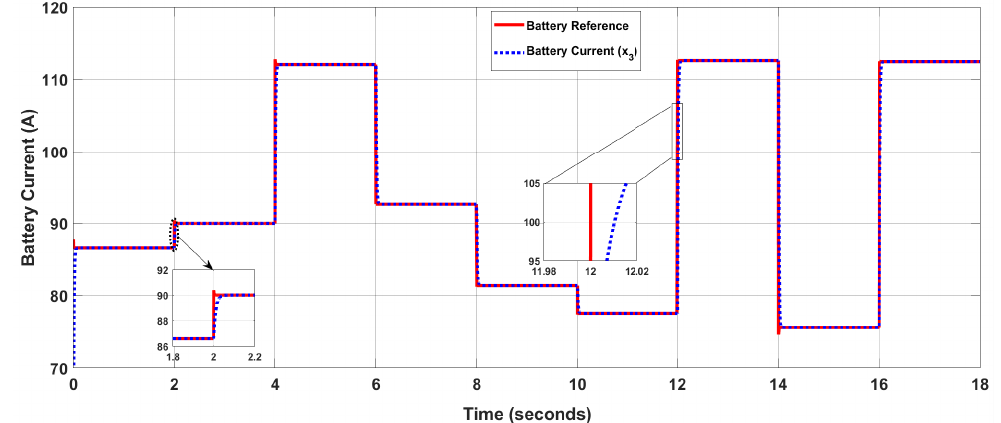
Figure 10. Battery current x 3 (case-I).